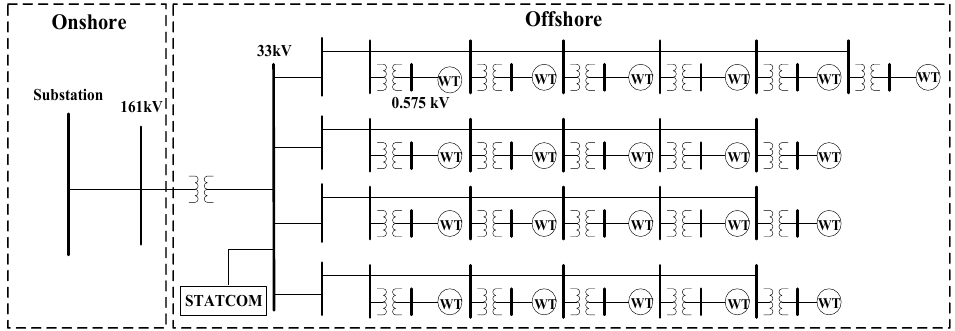
Figure 17. Single-line diagram of the offshore wind farm and STATCOM system under study.